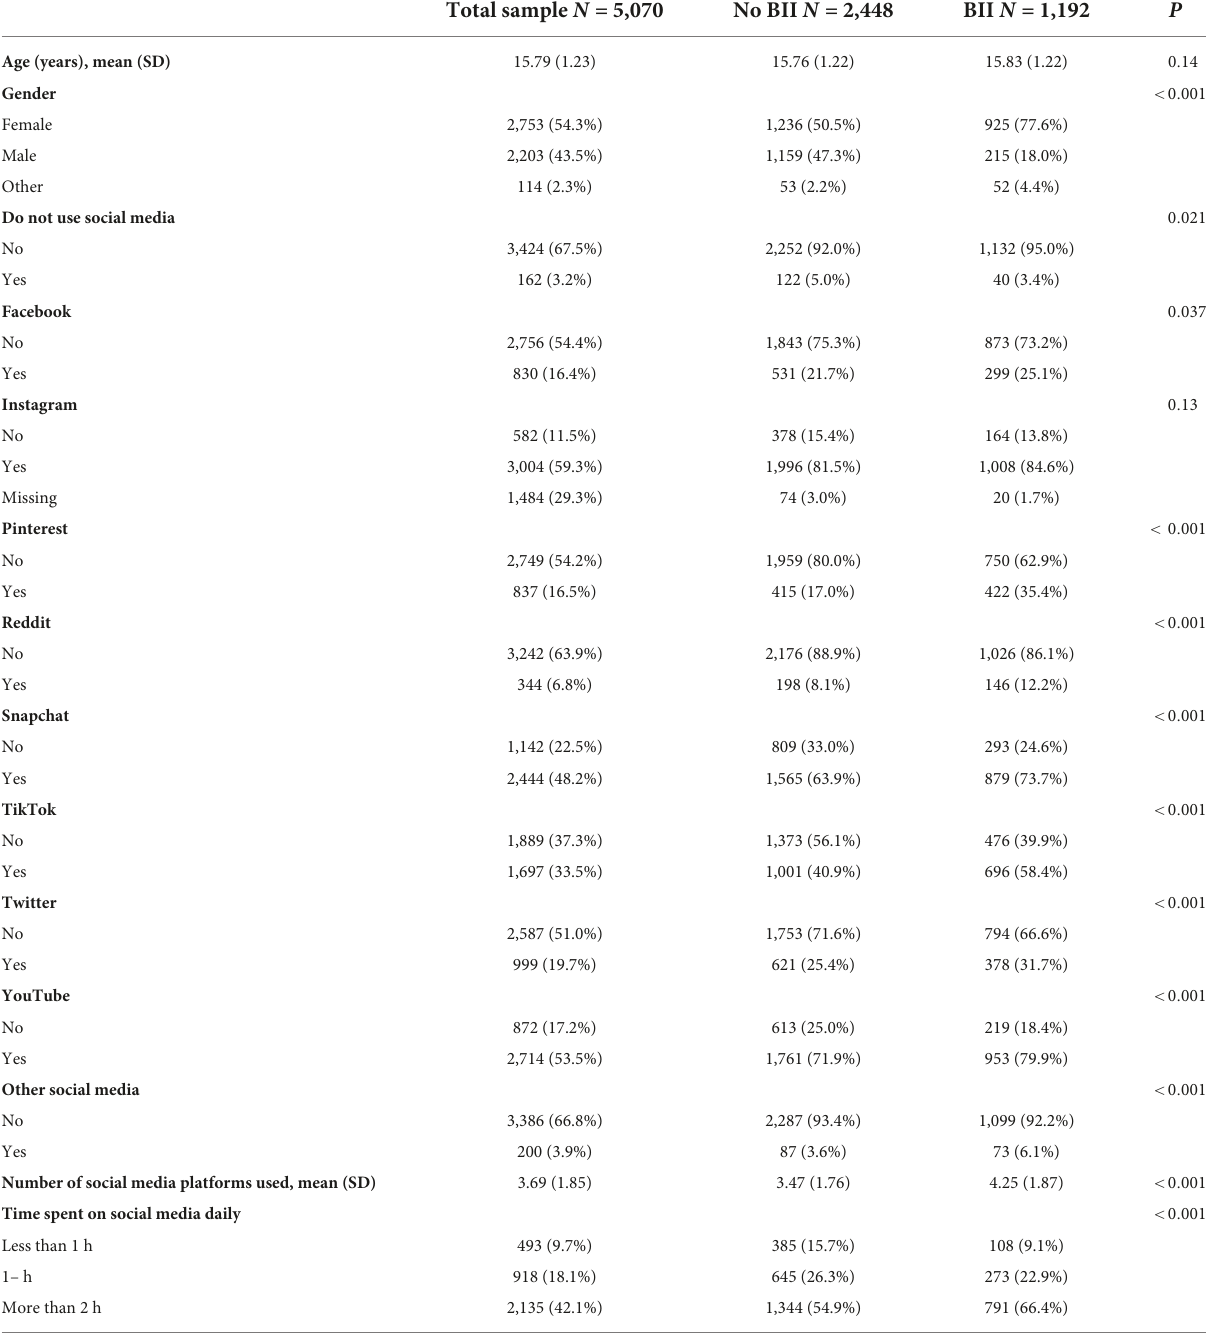
TABLE 2 Differences in social media (SM) use by self-report of body image issues